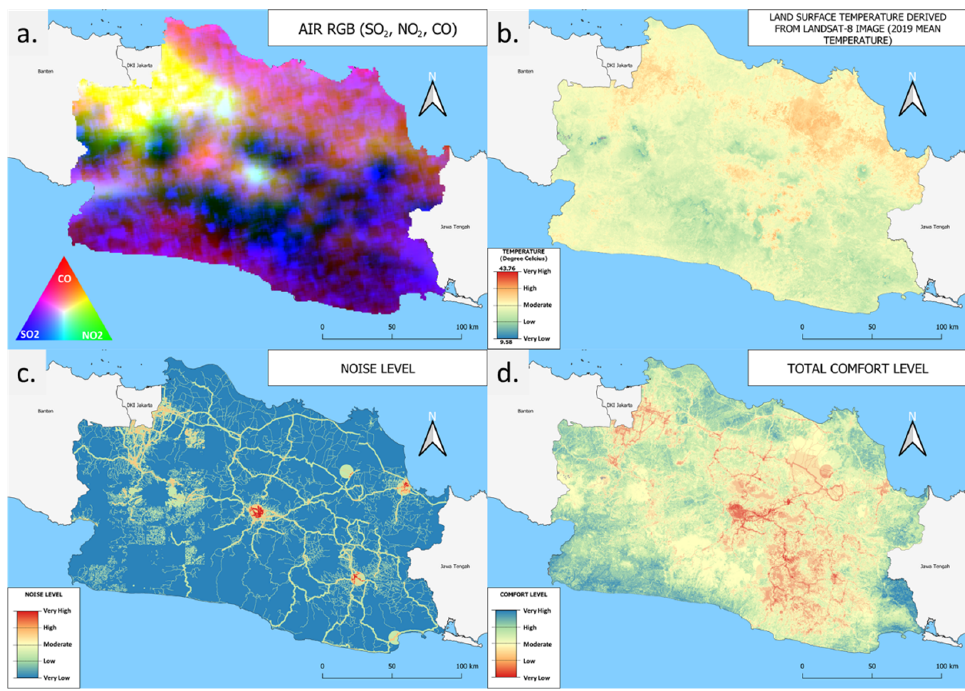
Figure 10. Distribution of: ( a ) air pollution, ( b ) LST (2019 average), ( c ) noise, and ( d ) total comfort levels.